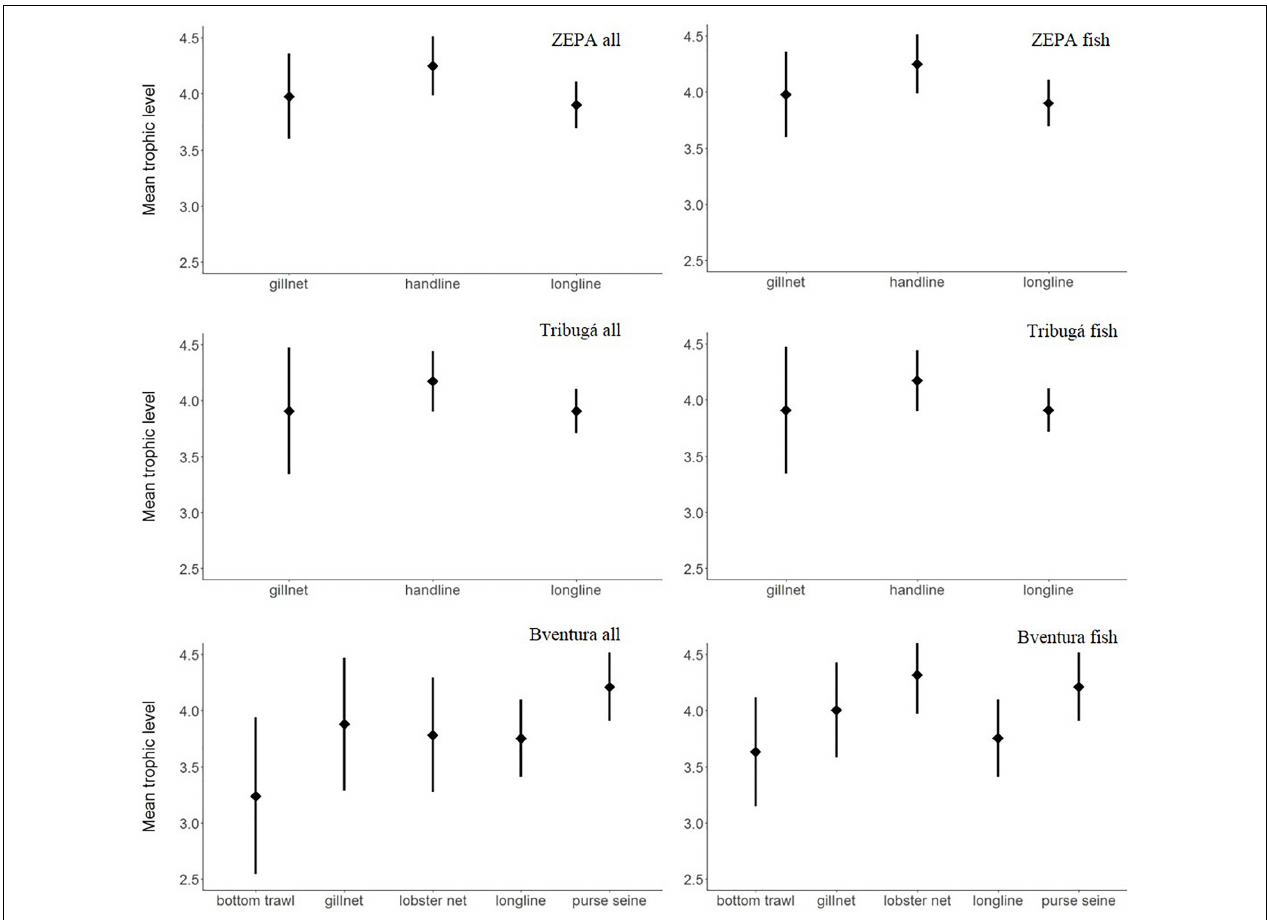
FIGURE 6 | Weighted mean and standard deviation of trophic level of the entire catch and of the fish portion of the catch of SSF per gear type at three coastal zones of the Colombian Pacific: ZEPA, Tribugá, and Buenaventura (abbreviation: